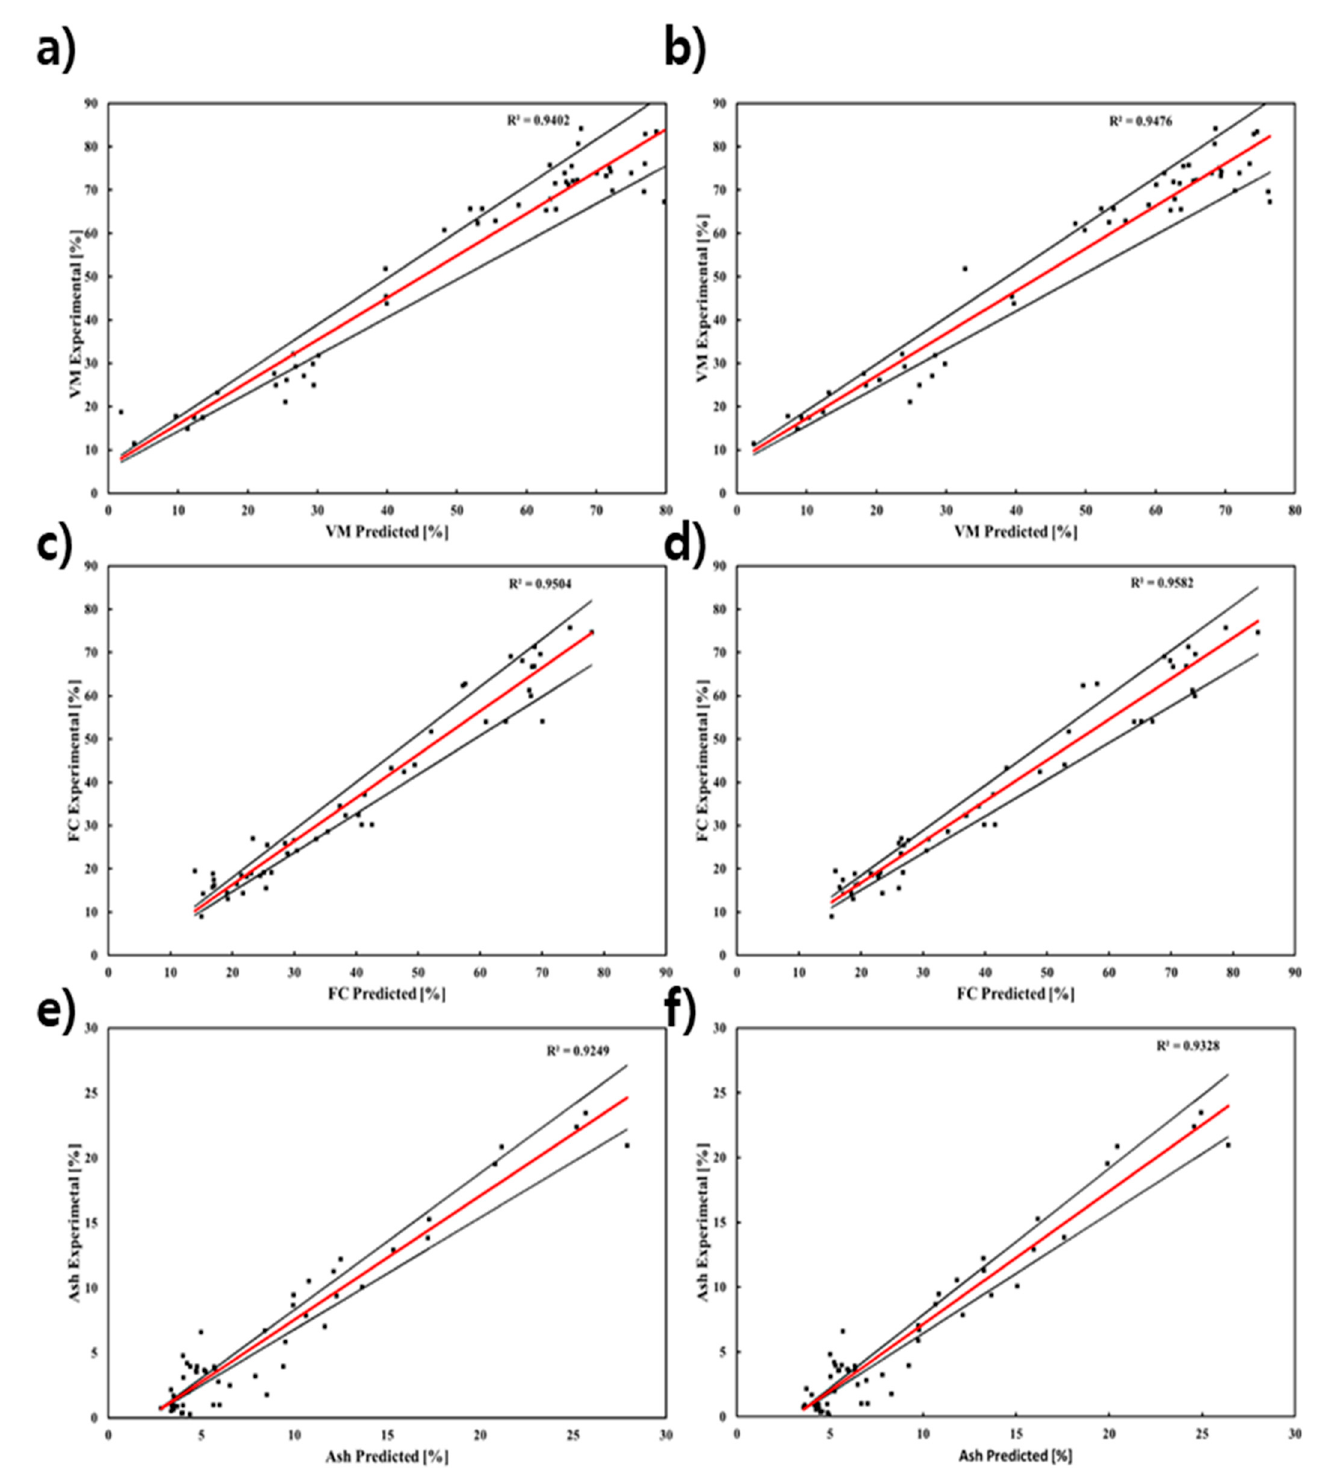
Figure 2. Scatter plots depicting the validation result of each model: ( a ) Equation (C9), ( b ) Equation (C13), ( c ) Equation (C23), ( d ) Equation (C28), ( e ) Equation (C31), and ( f ) Equation (C32).